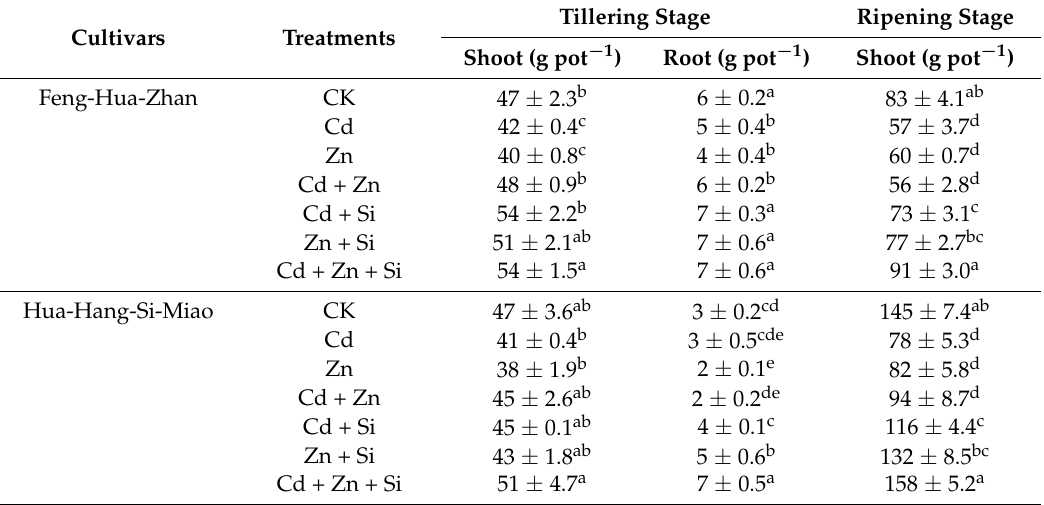
Table 1. Effect of Si addition on shoot and root dry weights of rice under heavy metal stress. Tillering Stage Ripening Stage Cultivars Treatments Shoot (g pot − 1 ) Root (g pot − 1 ) Shoot (g pot − 1 ) Feng-Hua-Zhan CK 47 ± 2.3 b 6 ± 0.2 a 83 ± 4.1 ab Cd 42 ± 0.4 c 5 ± 0.4 b 57 ± 3.7 d Zn 40 ± 0.8 c 4 ± 0.4 b 60 ± 0.7 d Cd + Zn 48 ± 0.9 b 6 ± 0.2 b 56 ± 2.8 d Cd + Si 54 ± 2.2 b 7 ± 0.3 a 73 ± 3.1 c Zn + Si 51 ± 2.1 ab 7 ± 0.6 a 77 ± 2.7 bc Cd + Zn + Si 54 ± 1.5 a 7 ± 0.6 a 91 ± 3.0 a Hua-Hang-Si-Miao CK 47 ± 3.6 ab 3 ± 0.2 cd 145 ± 7.4 ab Cd 41 ± 0.4 b 3 ± 0.5 cde 78 ± 5.3 d Zn 38 ± 1.9 b 2 ± 0.1 e 82 ± 5.8 d Cd + Zn 45 ± 2.6 ab 2 ± 0.2 de 94 ± 8.7 d Cd + Si 45 ± 0.1 ab 4 ± 0.1 c 116 ± 4.4 c Zn + Si 43 ± 1.8 ab 5 ± 0.6 b 132 ± 8.5 bc Cd + Zn + Si 51 ± 4.7 a 7 ± 0.5 a 158 ± 5.2